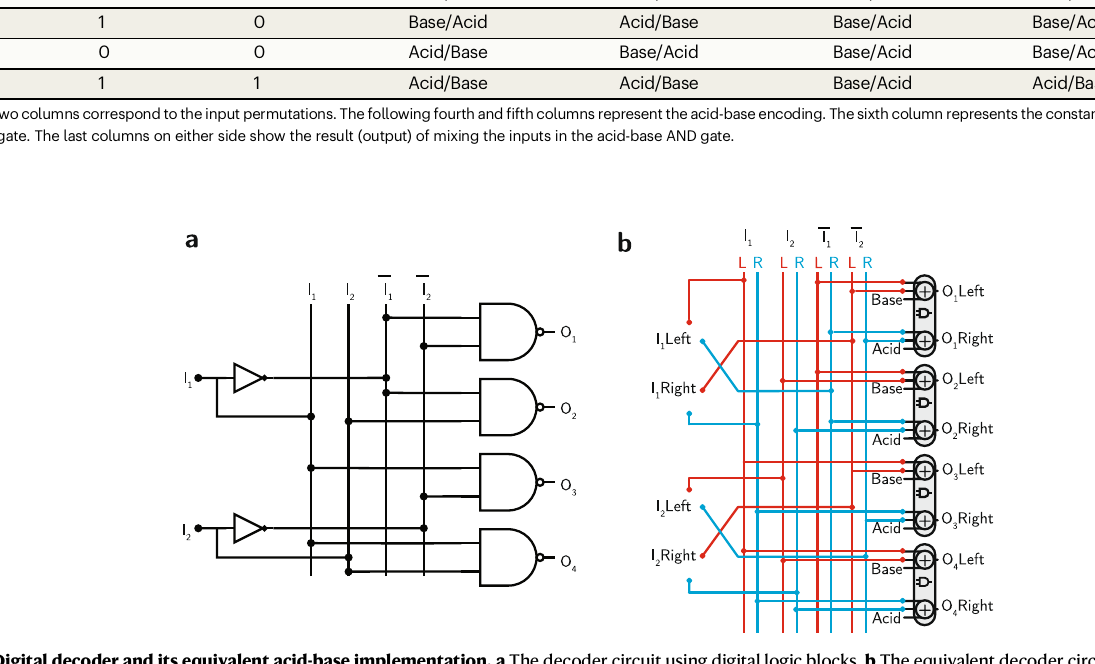
Fig. 3 | Digitaldecoderand itsequivalentacid-baseimplementation. a The decoder circuitusing digitallogic blocks. b Theequivalent decoder circuit using acid-base